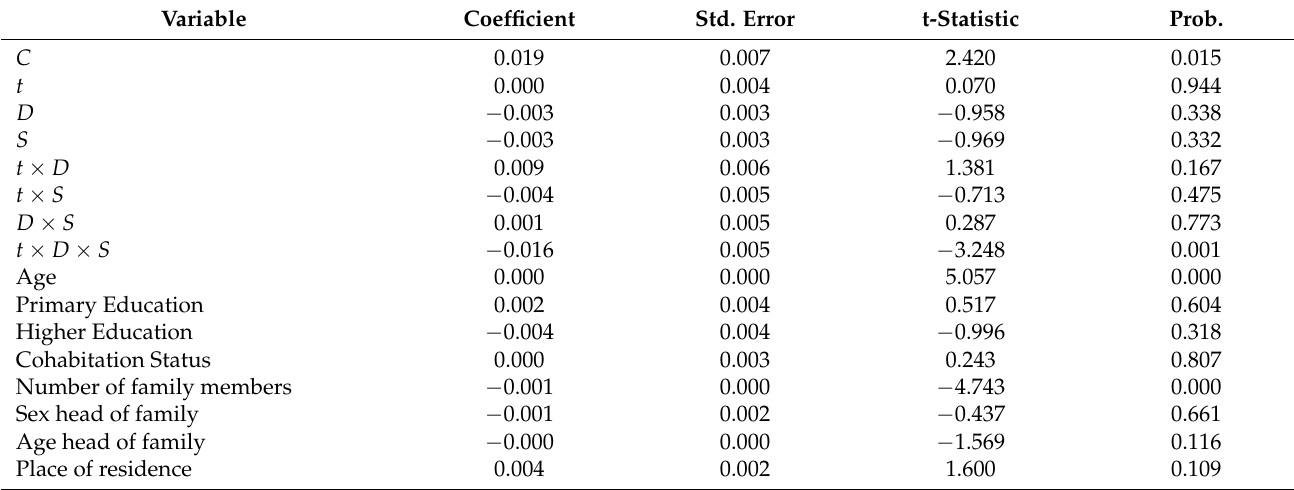
Table 6. Validation assuming the absence of